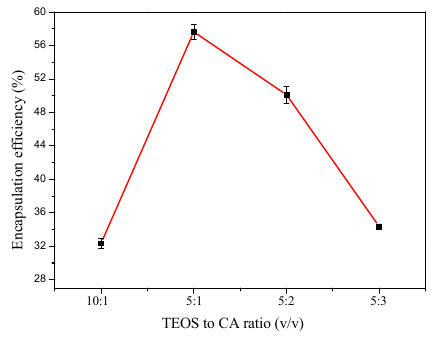
Figure 2. E ff ect of CA concentrations on the encapsulation e ffi Figure 2. Effect of CA concentrations on the encapsulation efficiency .